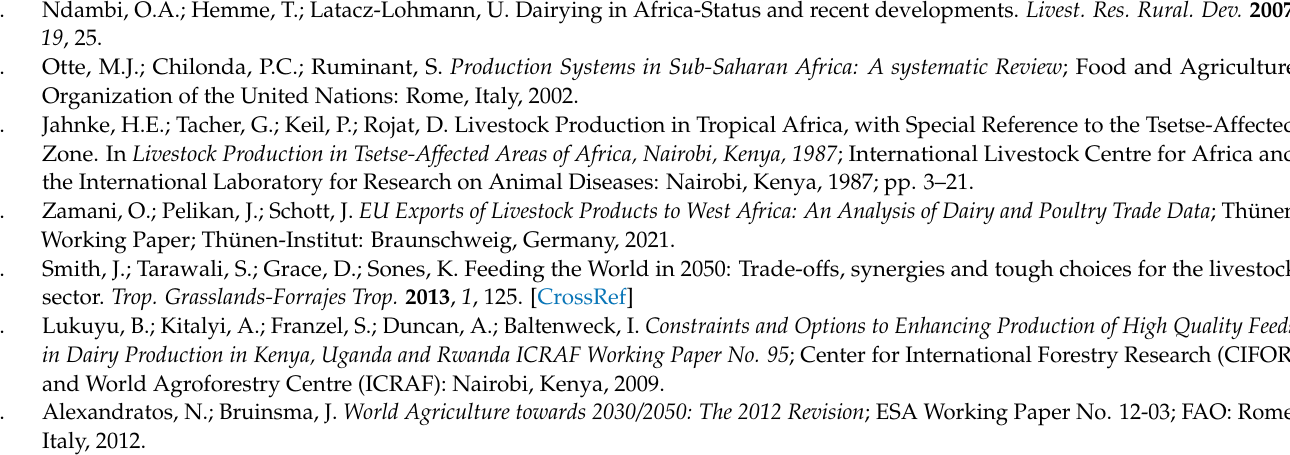
Table S2: overall supporting forces to forage adoption potential Mbuzii village; Table S3: overall supporting forces to forage adoption potential Ubiri village and Table S4: QATO-FT results per village; scoring values per